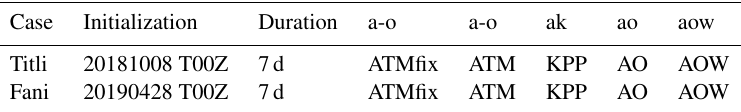
Ocean currents from a regional ocean model (e.g. IND1o) are applied as forcing in a wave model, read in from external files, with fields updated hourly.